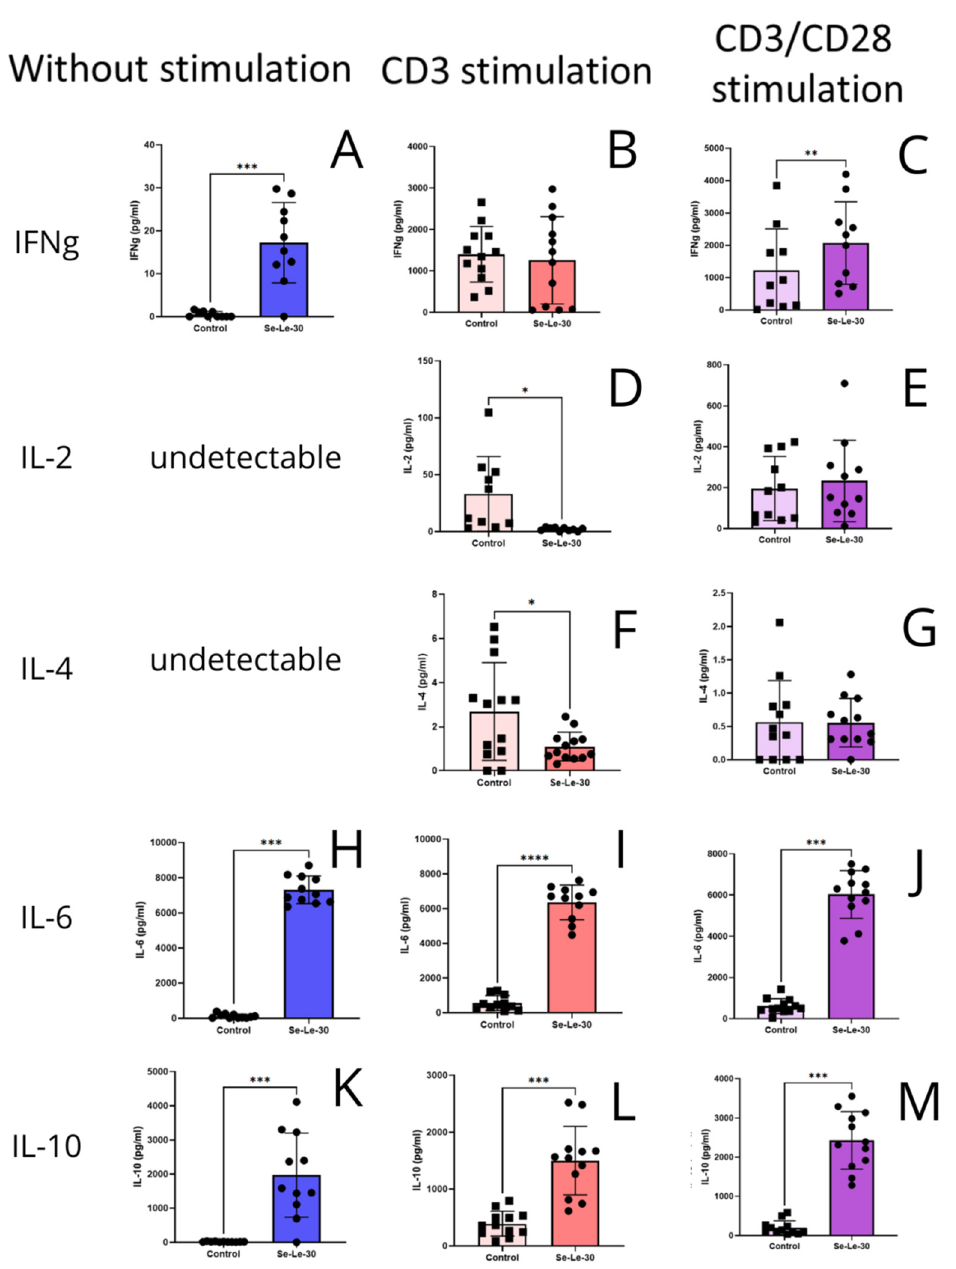
Figure 4. Effects of Se-Le-30 on cytokines secretion by PBMCs. PBMCs from 13 healthy donors were